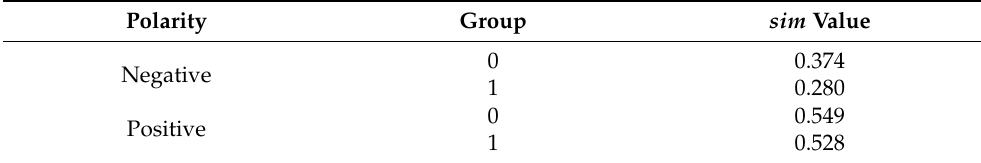
Table 3. sim results by polarity value and user